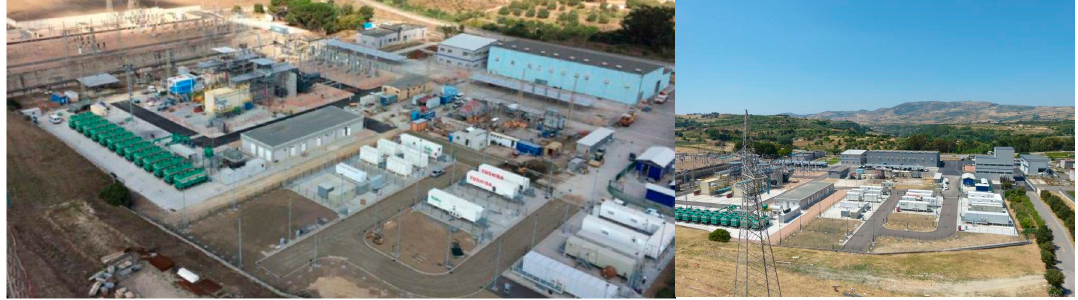
Figure 3. Two views from above the Codrongianos substation.